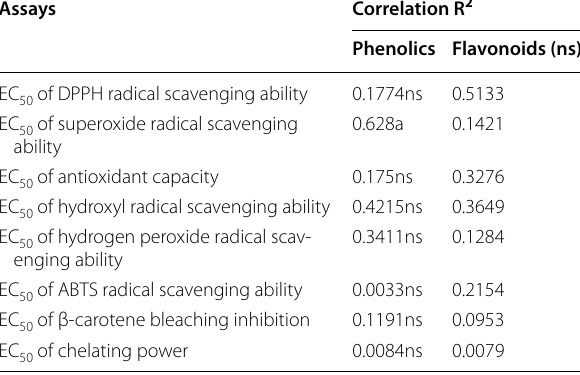
Table 3 Correlations between the EC dant activities and phenolic and flavonoids content of